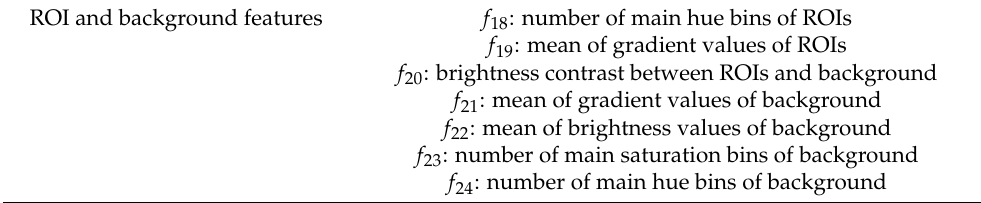
Table 6. Overview of the proposed handcrafted features F l